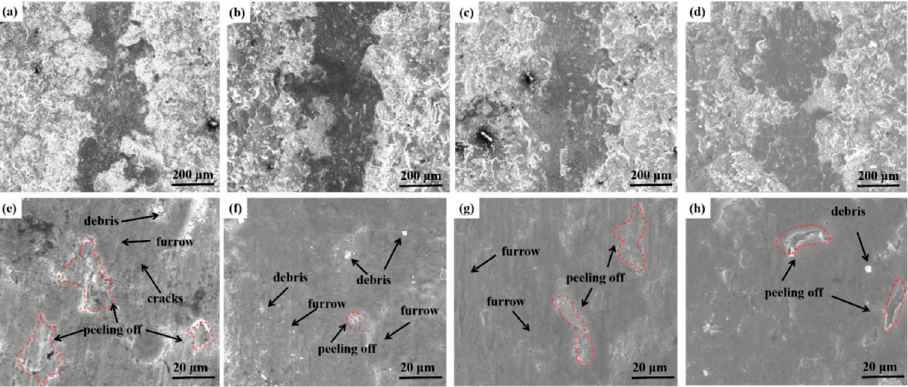
Figure 11. Wear scars of FeCoNiCrMo 0.2 high entropy alloy coating sprayed by plasma at different currents under 10 N load after shot peening treatment ( a , e ) 250 A, ( b , f ) 350 A, ( c , g ) 450 A, ( d , h ) 550 A.